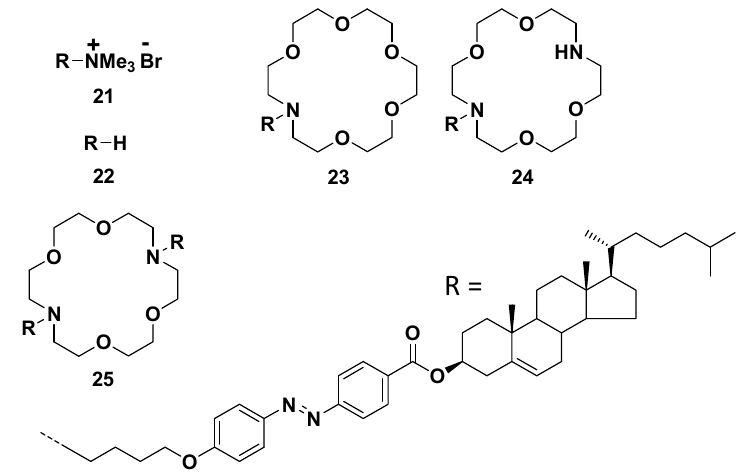
Chart 3. Cholesterol-based organogelators used for creating silica superstructures.